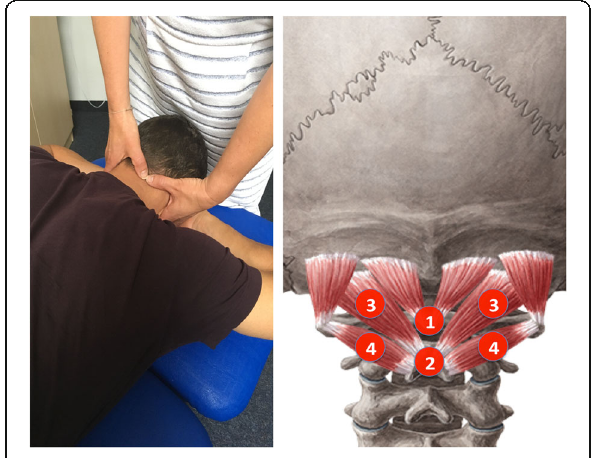
Fig. 1 Palpation of the upper cervical spine. 1 = midline